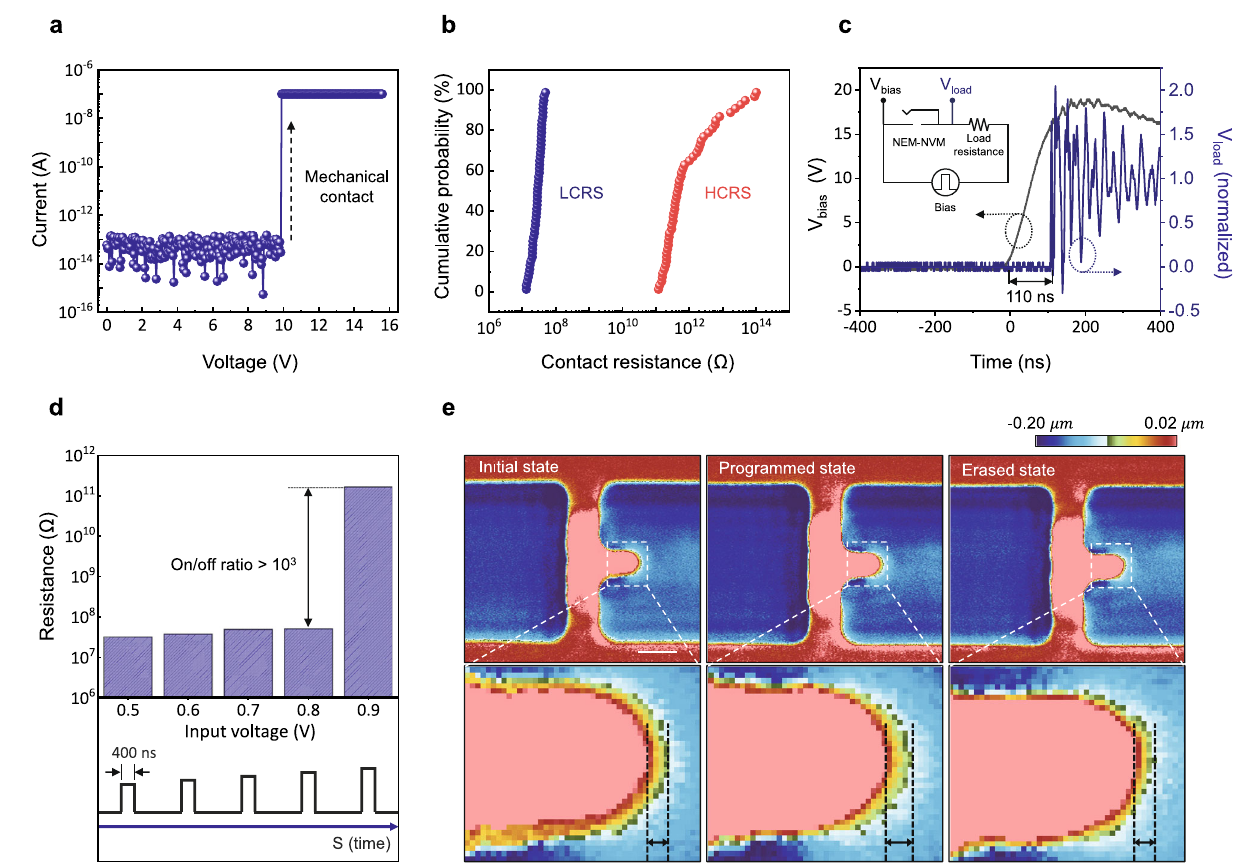
Fig. 3 | Electricaland opticalevaluations. a Current – voltage(I – V)characteristics of the fabricated NEM-NVM. At the sub-threshold region (V<V program ), an ultralow off-state current of less than 100fA was observed. The current curve increased abruptly at an applied voltage of 9.9V (compliance current of 100nA). b Contact resistance distribution represented by cumulative probability (total 100 devices). The blue circle represents the low contact resistance state (LCRS) of the pro- grammed device, and the red circle represents the high contact resistance state (HCRS) of the unprogrammed device. The contact resistance was measured through the four-point probe method at one-half programming voltage with